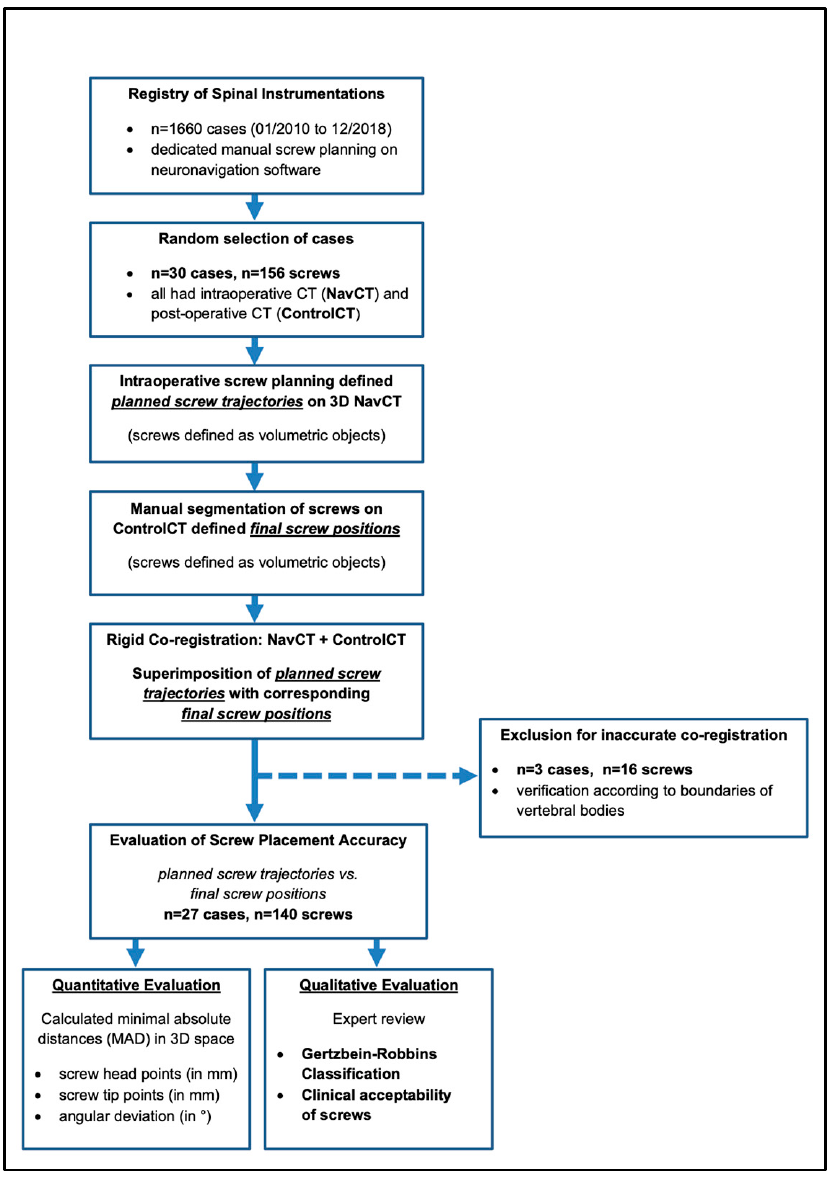
Figure 1. Flow diagram of case selection and workflow of data analysis.